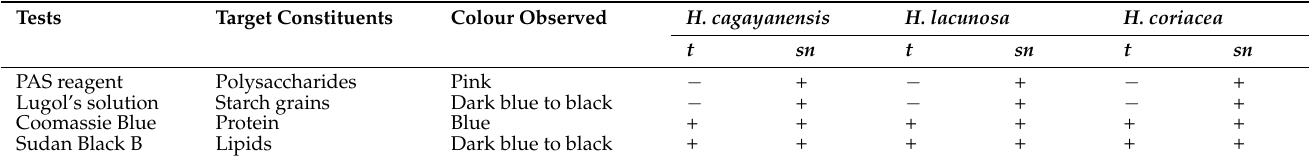
Table 2. Histochemical analysis of the trichomes ( t ) and secondary nectaries ( sn ) in flowers of the three Hoya